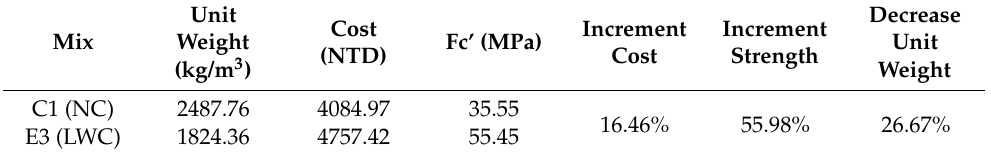
Table 9. Cost comparison results in NTD (New Taiwan